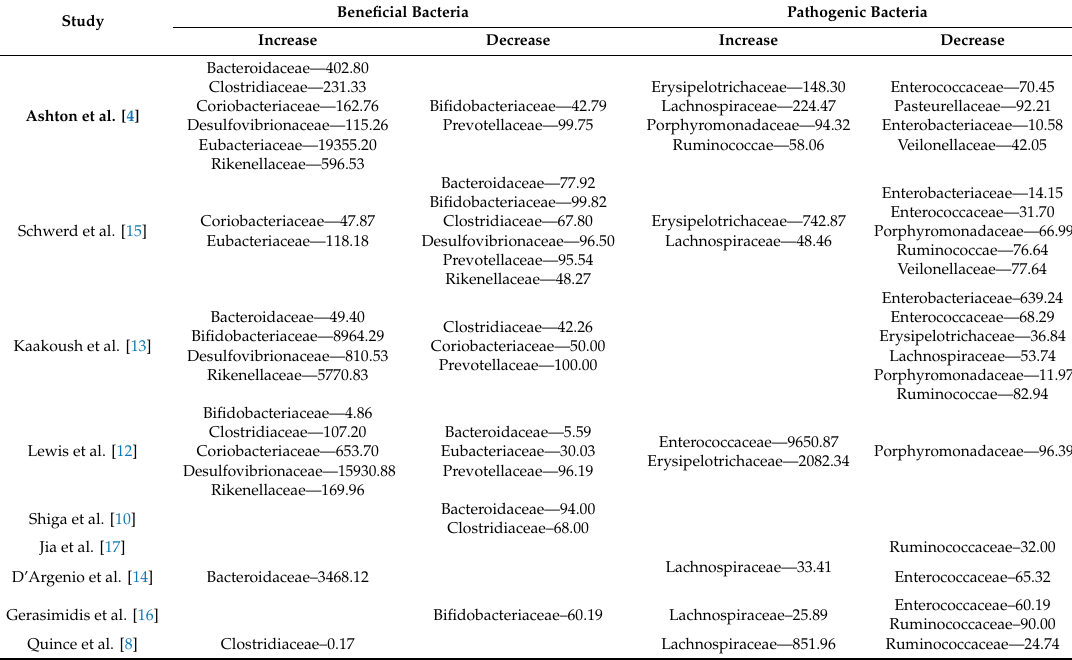
Table 4. Changes of microbiome—before and after treatment